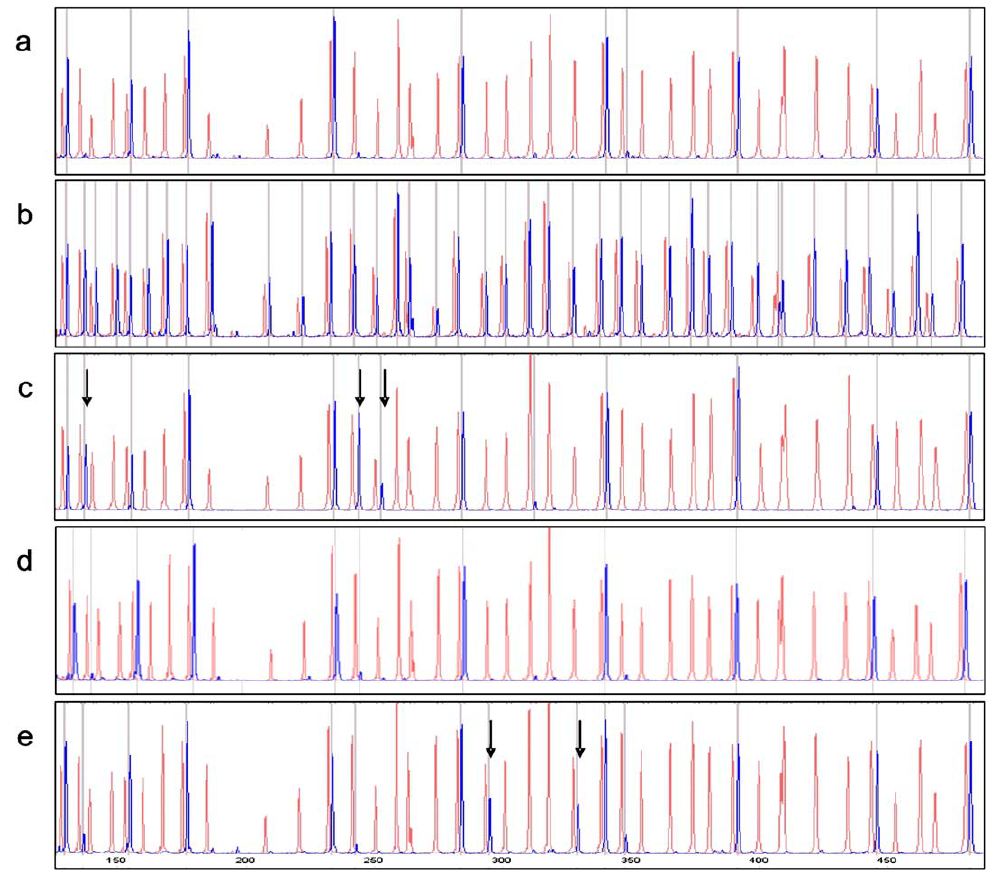
Fig. 1. Detection of aberrant methylation by MS-MLPA. MS-MLPA products were analyzed by capillary electrophoresis (CE). Profiles in red correspond with the undigested samples and blue with digested samples. MS-MLPA profiles are from (a) control genomic DNA without aberrant methylation, (b) SssI CpG methyltransferase treated control genomic DNA showing methylation of all target sequences, (c) genomic DNA derived from the CHRF-288 cell line, which shows FANCF methylation (blue peaks indicated by arrows), (d) genomic DNA from an AML sample without methylation and (e) genomic DNA from an AML sample showing FANCC methylation (blue peaks indicated by arrows). 5 (cid:4) -TTAGTTTTGTGGATTTGAGGGTAAT-3